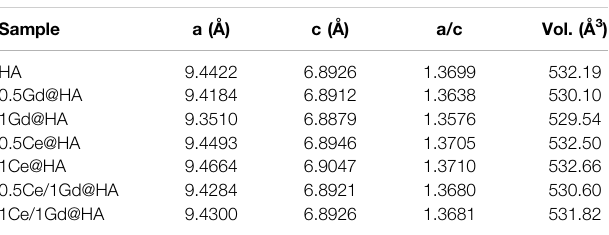
TABLE 1 | Crystallographic parameters of Ce/Gd co-doped HA.